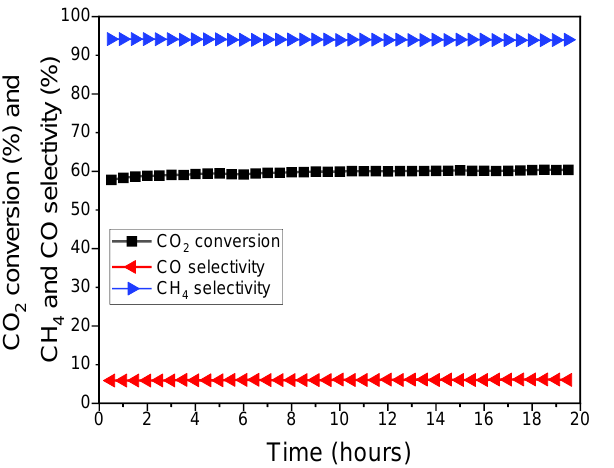
Figure 2. Stability experiment of NiRu/CeAl, showing CO 2 conversion and CO and CH 4 selectivity (CO 2 /H 2 /N 2 : 1/4/5, T = 350 ◦ C, P = 1 atm, WHSV = 400 L · g − 1 · h − 1 (CO 2 /H 2 /N 2 : 1/4/5, T = 350 °C, P = 1 atm, WHSV = 400 L·g −1 ·h −1 ).